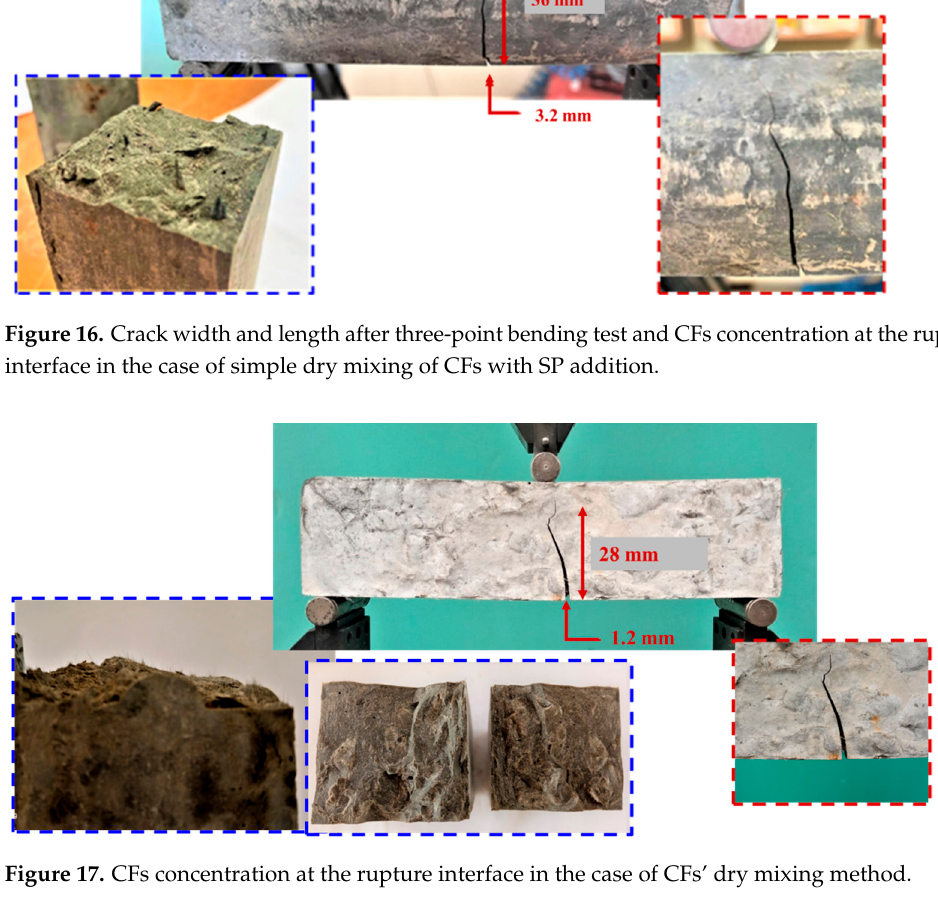
Figure 17. CFs concentration at the rupture interface in the case of CFs’ dry mixing method.